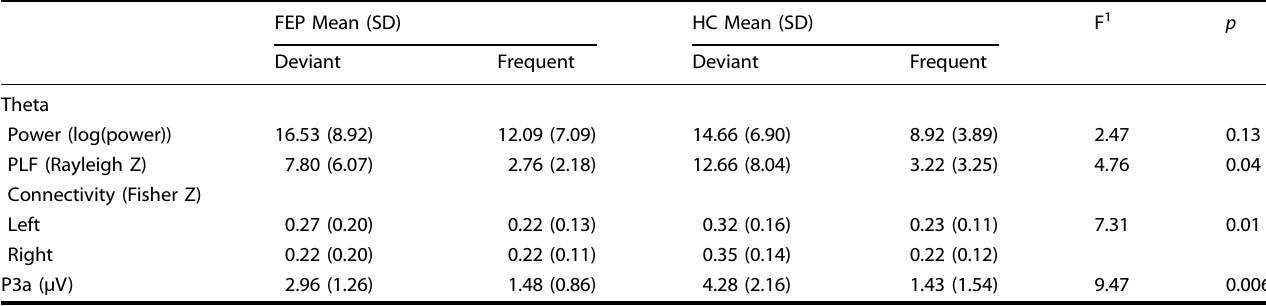
Table 2. Neurophysiological variables in each